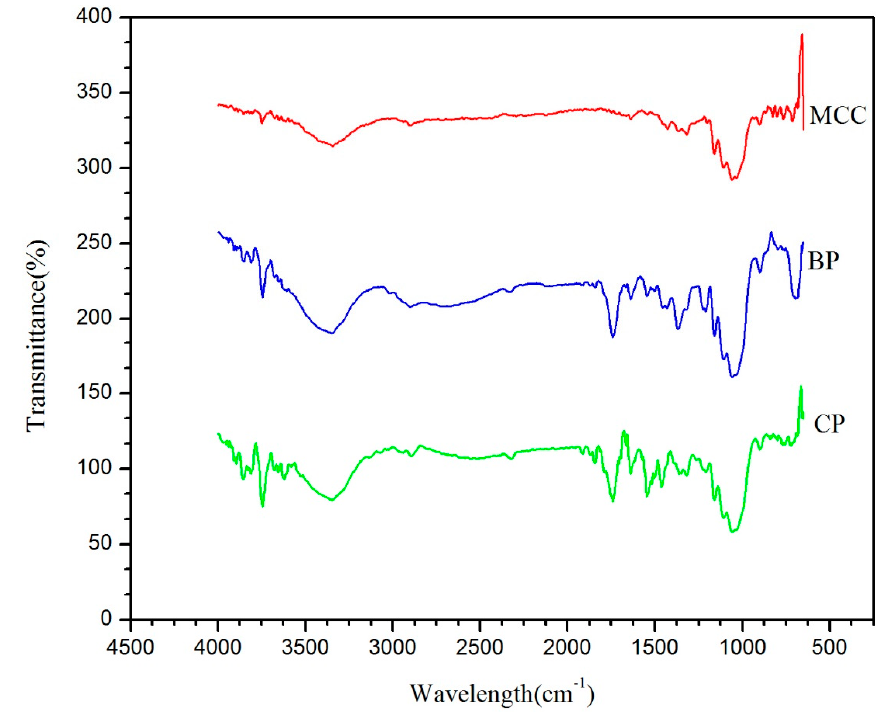
Figure 3. FTIR spectra of MCC, B-PULP, and C-PULP samples are shown in this figure. All samples were analysed in the range 4500 cm − 1 to 500 cm − 1 of wavelength and the change in functional group intensity was recorded and reported in the results section.